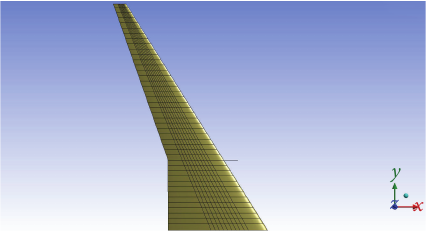
Figure 1: Swept wing model.